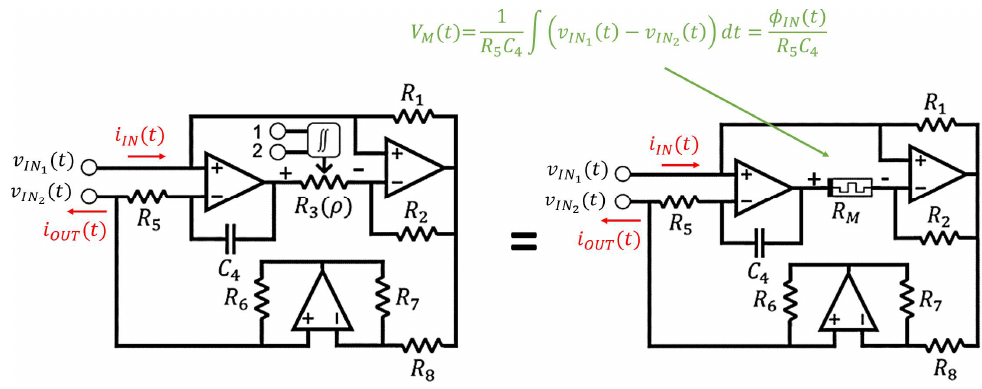
Figure 11. Floating meminductor emulator circuit proposed by Romero et al. [50].